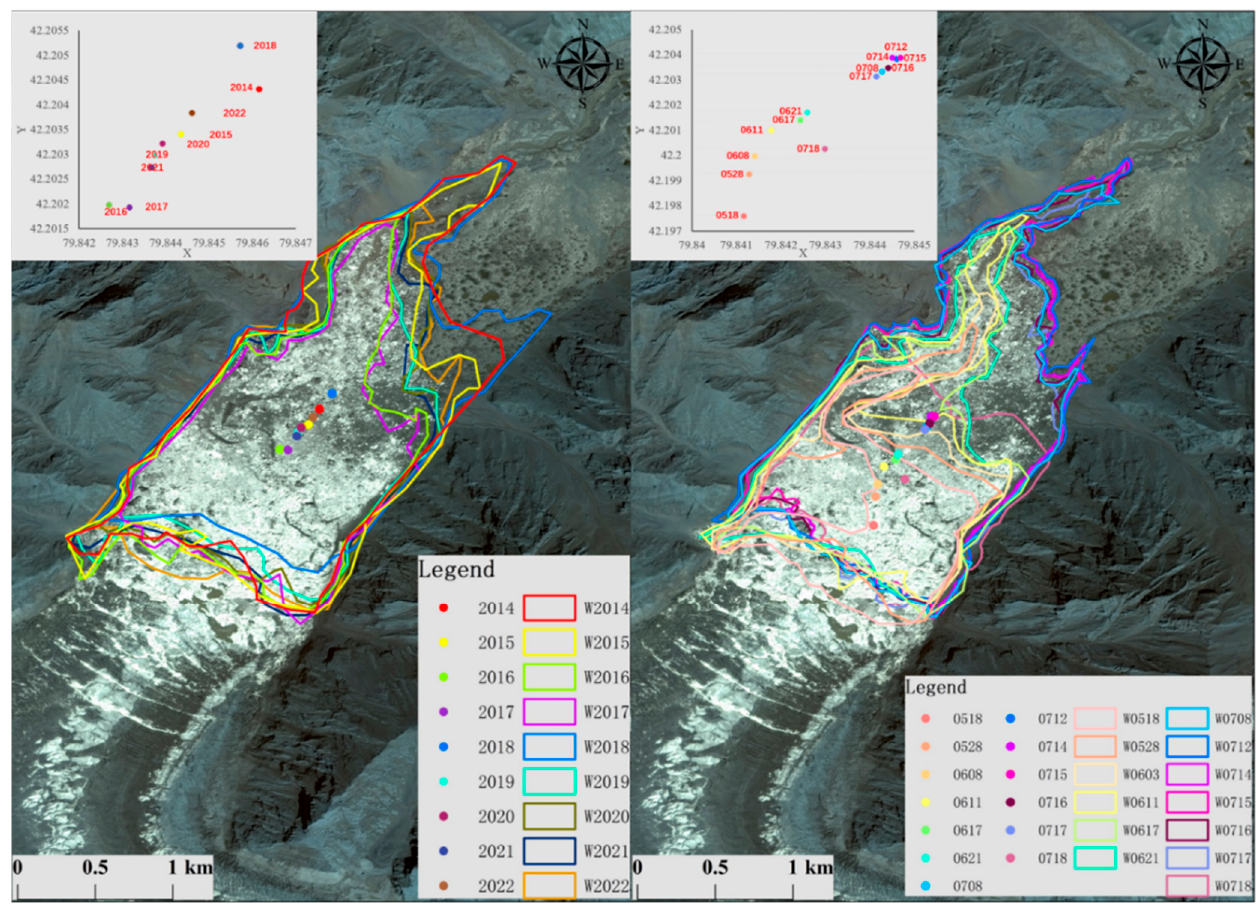
Figure 5. Centroid changes of lake area in historical and 2022 before the outburst.